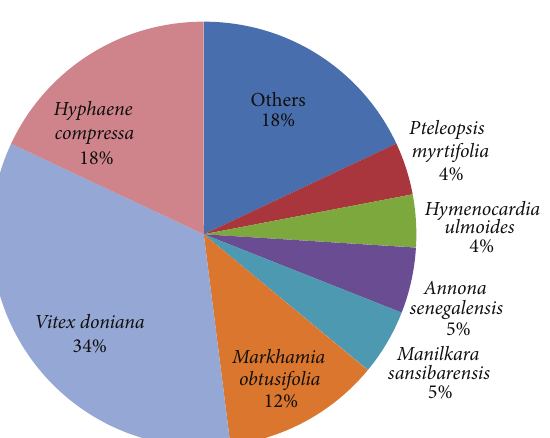
Figure 3: Percentage distribution of regenerants in closed forest